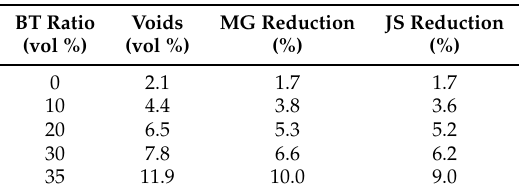
Table 4. Void volumes inside the dielectric samples, with the percentage reduction in permittivity due to the voids as predicted by the MG and JS